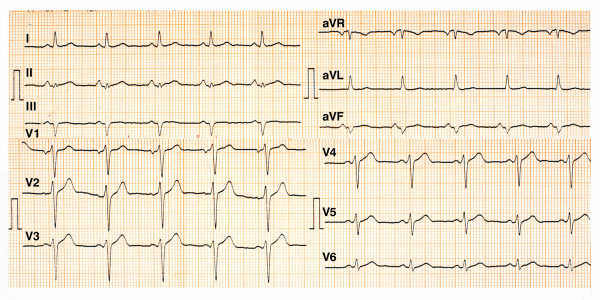
ECG recorded on hospital day 4th.